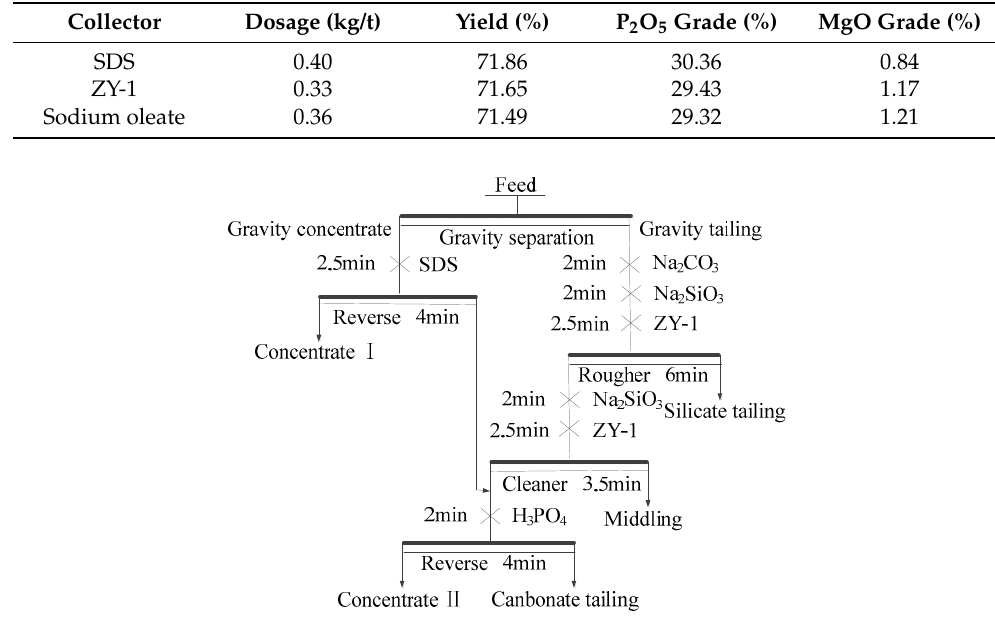
Figure 6. Improved gravity-flotation combination process.